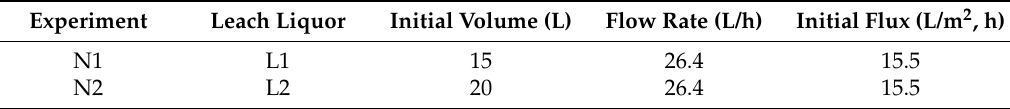
Table 4. Acid recovery by nanofiltration performed at room temperature.